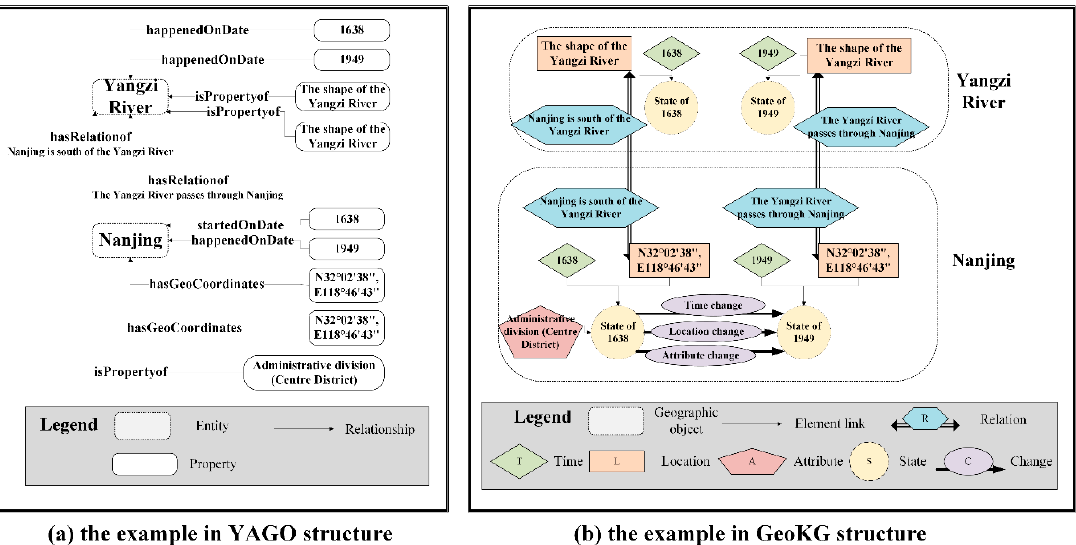
Figure 8. The examples with structures of the YAGO model and the GeoKG model. ( a ) the entities, properties and relationships in YAGO structure; ( b ) the elements in GeoKG structure.